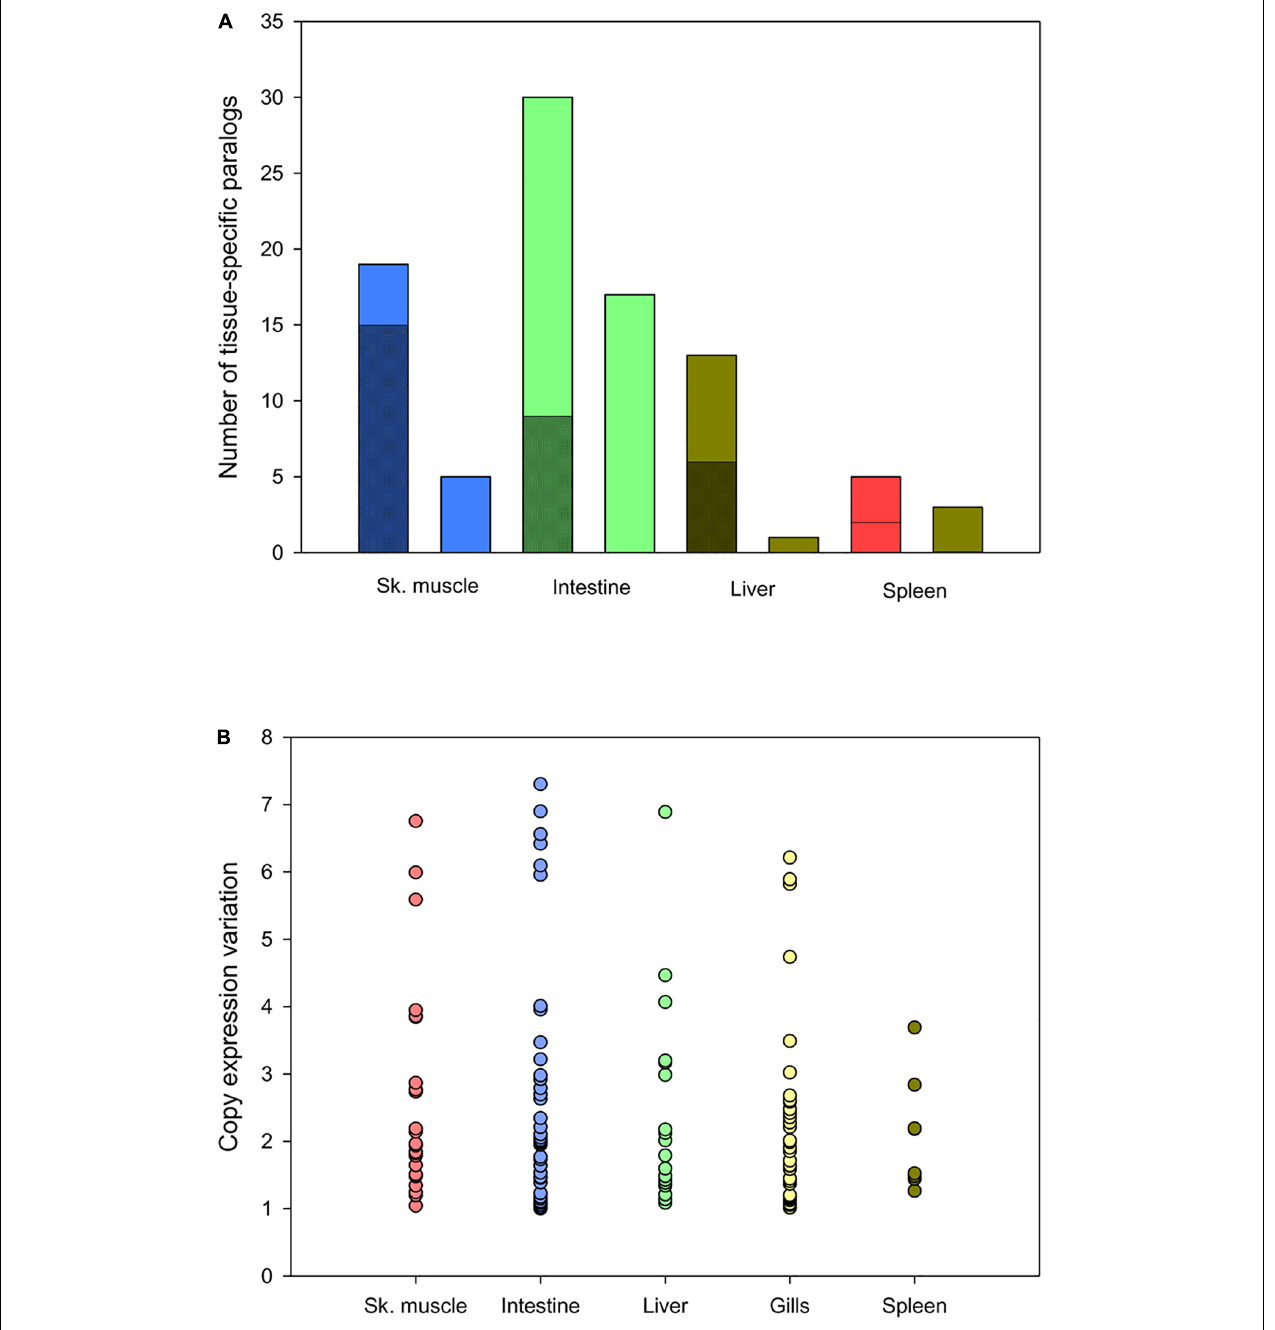
FIGURE 6 | Comparison of tissue-exclusive paralogs and gene expression Atlas in animal models. (A) Classification of tissue-exclusive paralog expression enrichment in animal models according to gene expression atlases: enriched in tissue (checkered stacked bar), enriched in tissue and/or other tissues (diagonal stripped stacked bar) and expressed in all tissues (smooth colored column). (B) Scatter plot showing the range of expression variation in tissue-exclusive paralogs. Each point represents the variation value for each paralog between the most and the less expressed copies.